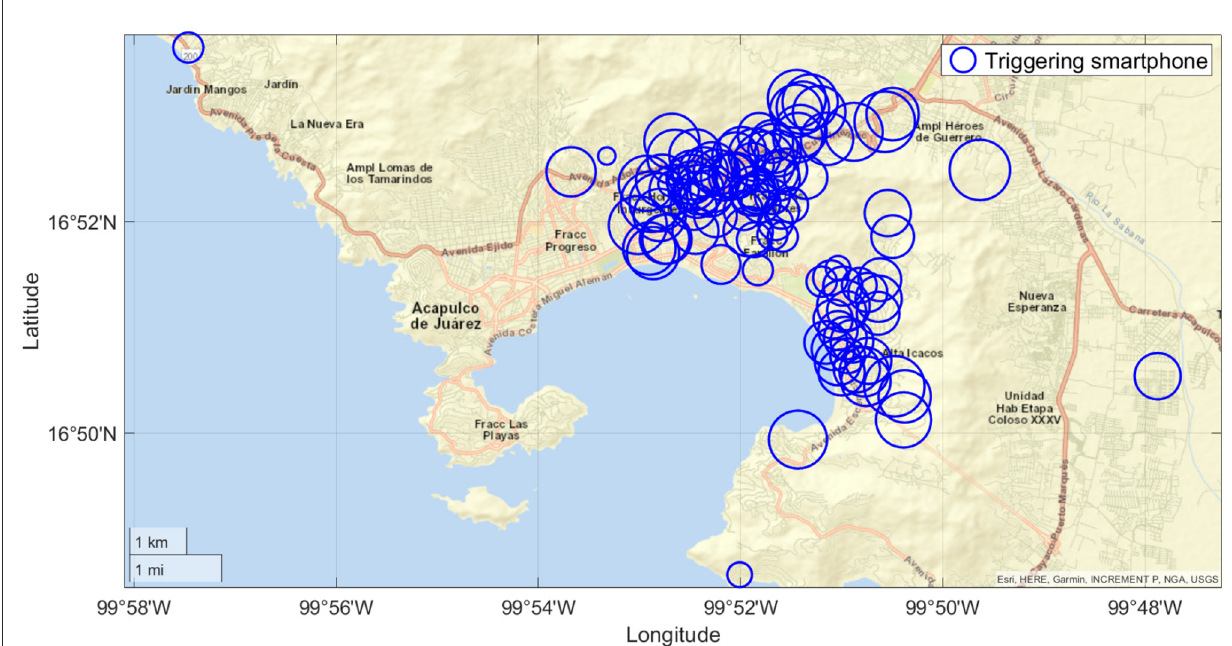
FIGURE6 Triggers for the false EQN detection occurred on 25 September 2022, close to Acapulco (Mexico). The diameter of circles is proportional to the triggering